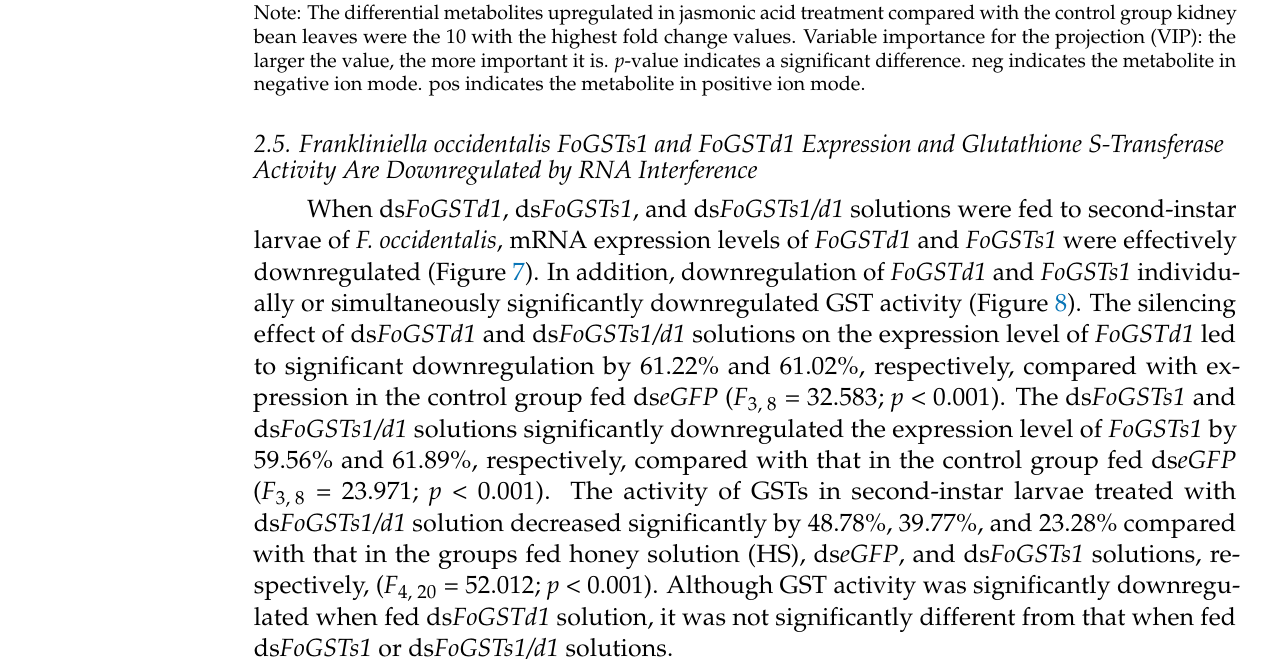
Figure 8. Effects of downregulation of FoGSTs1 and FoGSTd1 expression levels by RNA interfer- ence on glutathione S-transferase activity in second-instar larvae of Frankliniella occidentalis . Values are the mean ± SE. Different lowercase letters indicate significant silencing among all treatments ( p < 0.05; one-way ANOVA, followed by Tukey’s test). 2.6. Co-Silencing of FoGSTd1 and FoGSTs1 Expression by RNA Interference Reduces the Feed- ing Ability of Frankliniella Occidentalis When the expression of FoGSTd1 and FoGSTs1 was co-silenced, the area of feeding damage by second-instar larvae of F. occidentalis on kidney bean leaves treated with exog- enous JA and MeJA decreased significantly (Figure 9). The area of feeding damage on JA- and MeJA-induced kidney bean leaves by second-instar larvae fed HS decreased signifi- cantly by 28.82% and 38.49% ( F 2, 15 = 25.451; p < 0.001), respectively, compared with feeding on control leaves without induction treatment. Compared with the control, the area of feeding damage on JA- and MeJA-induced bean leaves by F. occidentalis fed ds eGFP solu- tion decreased significantly by 26.35% and 30.31% ( F 2, 15 = 13.360; p < 0.001), respectively, whereas the area of feeding damage on JA- and MeJA-induced kidney bean leaves by F.